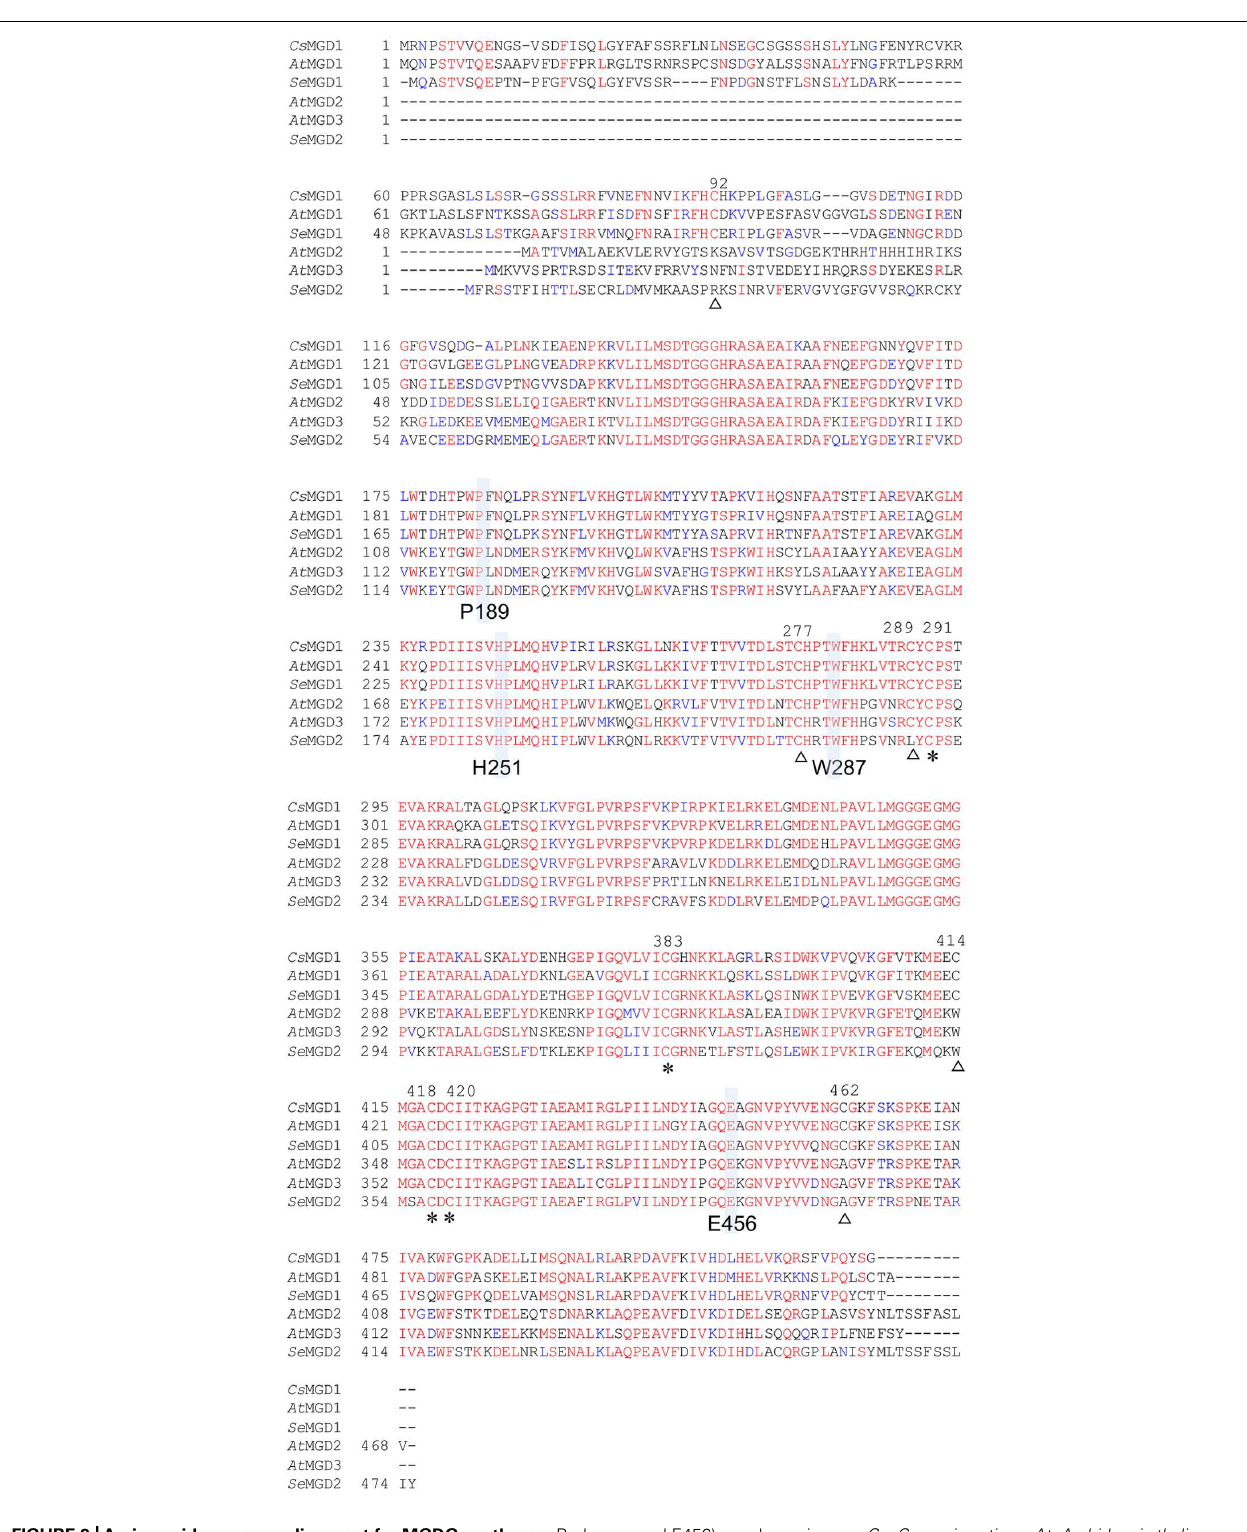
and E456) are shown in gray. Cs , Cucumis sativus ; At , Arabidopsis thaliana ; Se , Sesamum indicum L. Accession numbers are Cs MGD (P93115), At MGD1 (NP_849482), Se MGD1 (AB841066), At MGD2 (NP_568394), At MGD3 (NP_565352), and Se MGD2